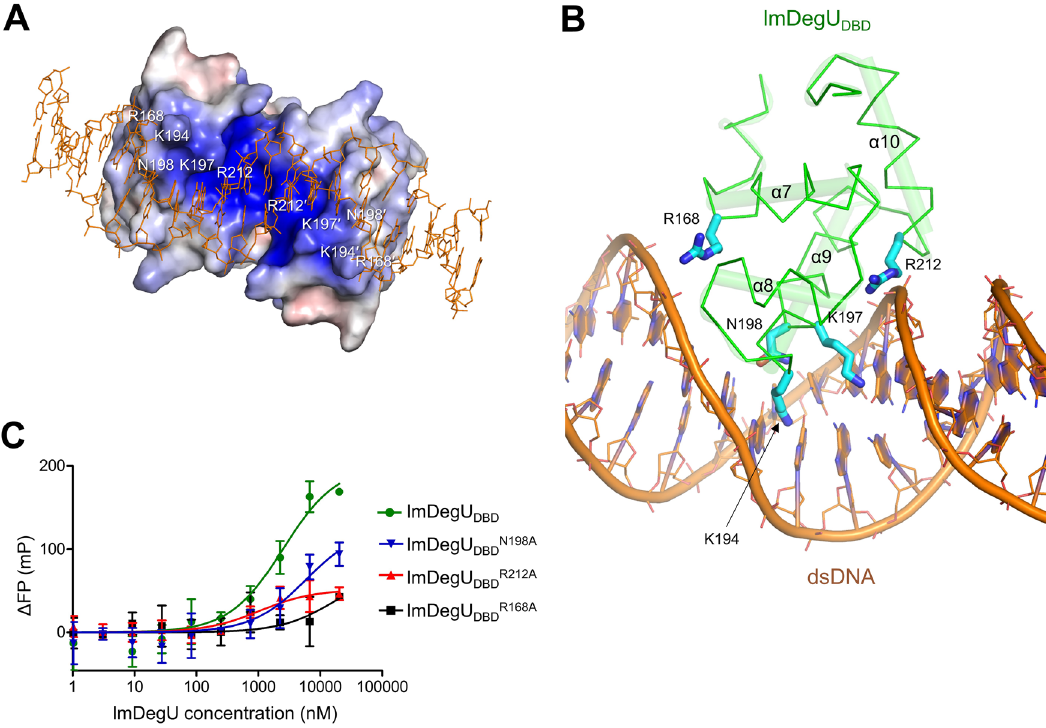
Figure 4. dsDNA-binding residues of lmDegU DBD . ( A ) Putative dsDNA-binding residues of lmDegU DBD (white labels) in the model of a complex between the lmDegU DBD dimer (electrostatic potential surfaces) and dsDNA (orange lines). In the model, dsDNA resides on the positive electrostatic potential surface of the lmDegU DBD dimer. ( B ) Interactions of the lmDegU R168, K194, K197, N198, and R212 residues (cyan sticks) with dsDNA in the model of a complex between the lmDegU DBD monomer (green Cα traces with transparent cylindrical helices) and dsDNA (orange lines and cartoons with filled base rings). ( C ) Mutagenesis-based verification of the dsDNA-binding surface of lmDegU DBD . The dsDNA-binding affinities of the lmDegU DBD R168A , lmDegU DBD N198A , and lmDegU DBD R212A mutants were analyzed by the FP assay in comparison with that of lmDegU DBD . The data (means ± S.D.) are representative of five independent experiments that yielded similar results.